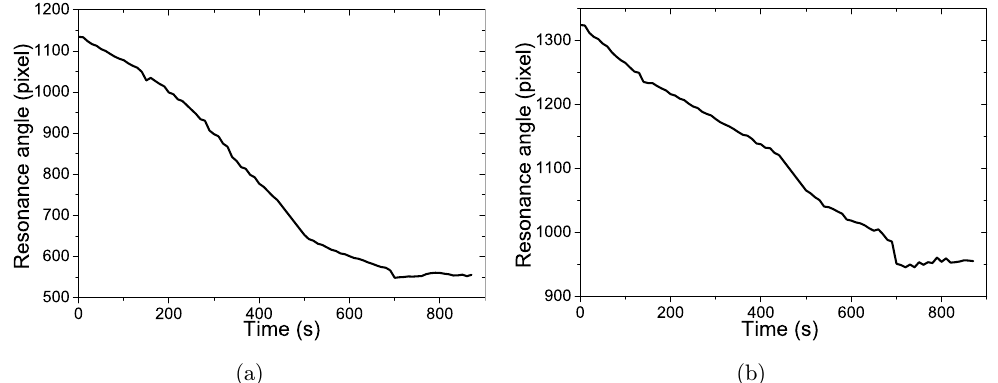
Fig. 3. (a), (b) The measured resonance angles in reference, detection channels as the function of time for polydopamine ¯lm